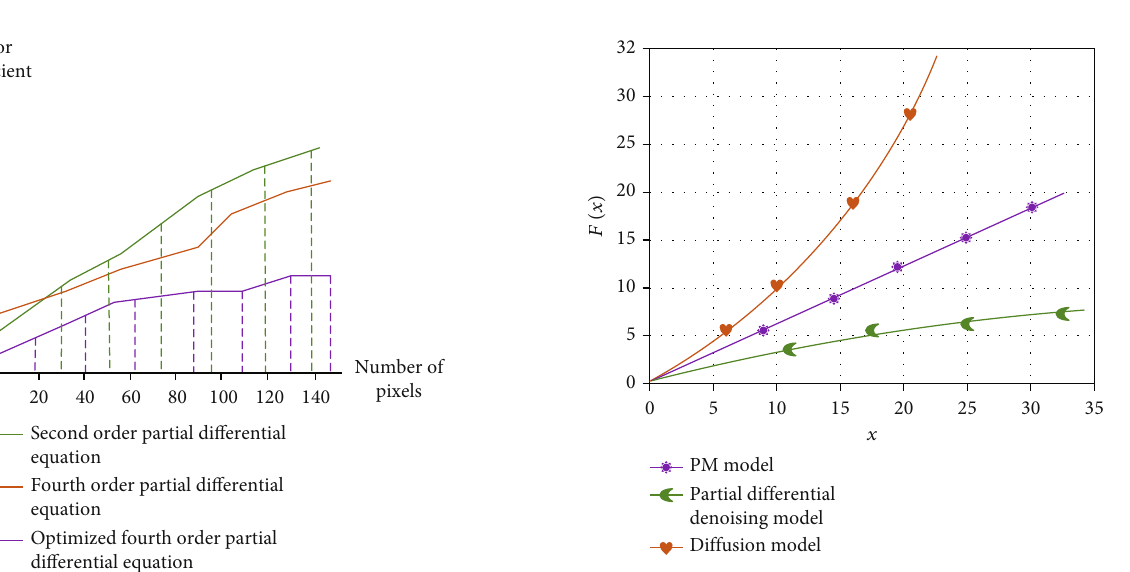
Figure 4: Comparison of error coe ffi cients of second-order partial di ff erential equation, fourth-order partial di ff erential equation, and optimized fourth-order partial di ff erential